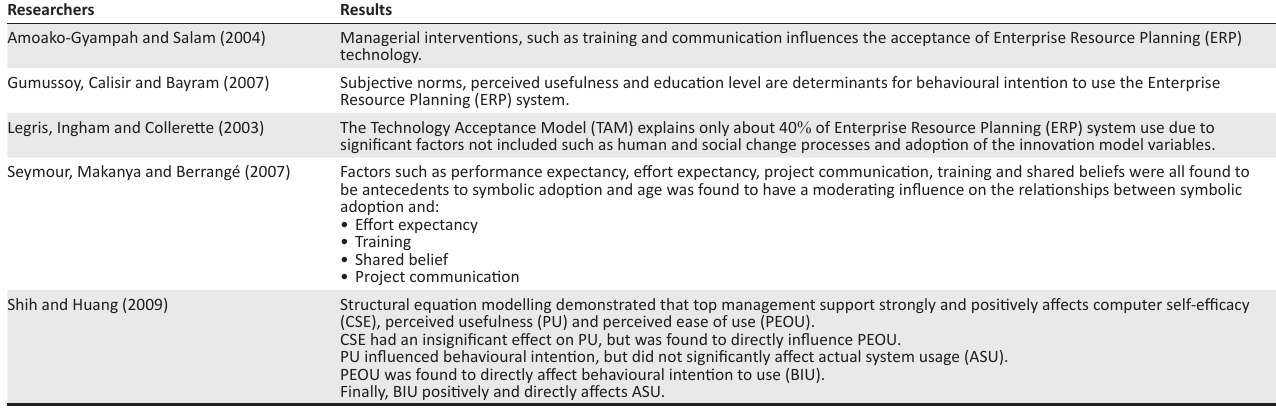
TABLE 1: Examples of TAM research in the ERP environment. Researchers